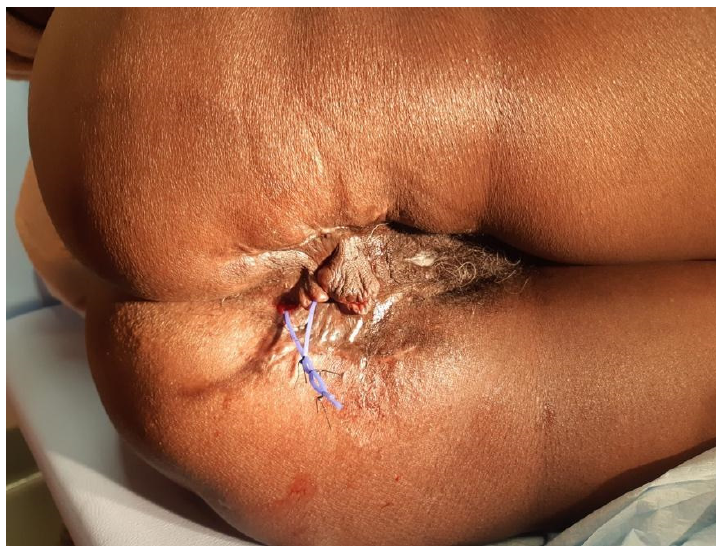
Figure 4. The outcome of the perineal region with the seton placed.